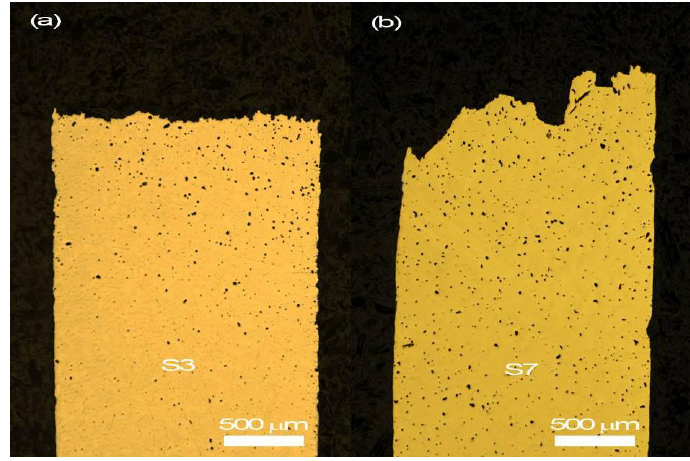
Figure 12. Macroscopic fracture surface of the tensile specimens ( a ) S3 and ( b ) S7.